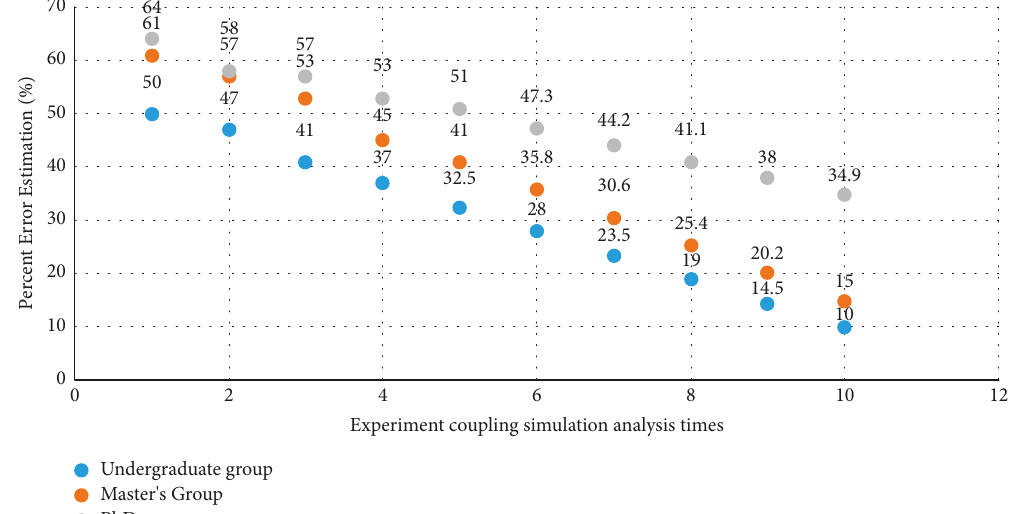
Figure 3: The percentage error obtained under the number of experiments with different degrees of